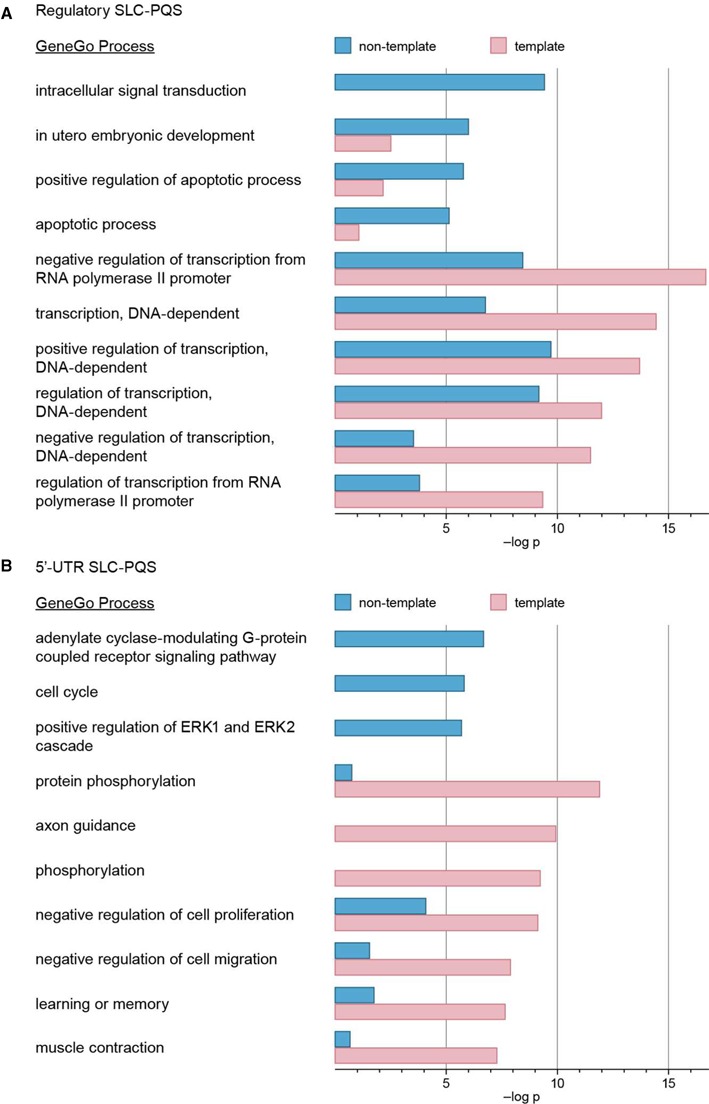
Gene ontology (GO) analysis of SLQS from different gene segments. Examples of GeneGo process categories (MetaCoreTM) which are found to be significantly enriched with (A) promoter SLQS located at gene regulatory loci and (B) SLQS located at 5′-UTR, on either the template (pink) and/or non-template (blue) strands. The P-values are presented as negative logarithms.